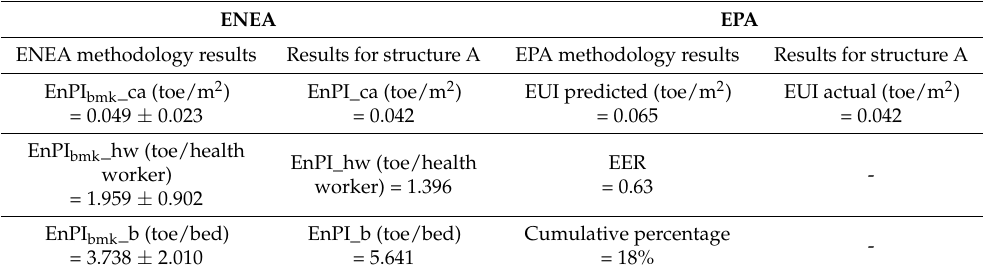
Table 7. Results of the comparison between ENEA methodology and EPA methodology for struc- ture A.